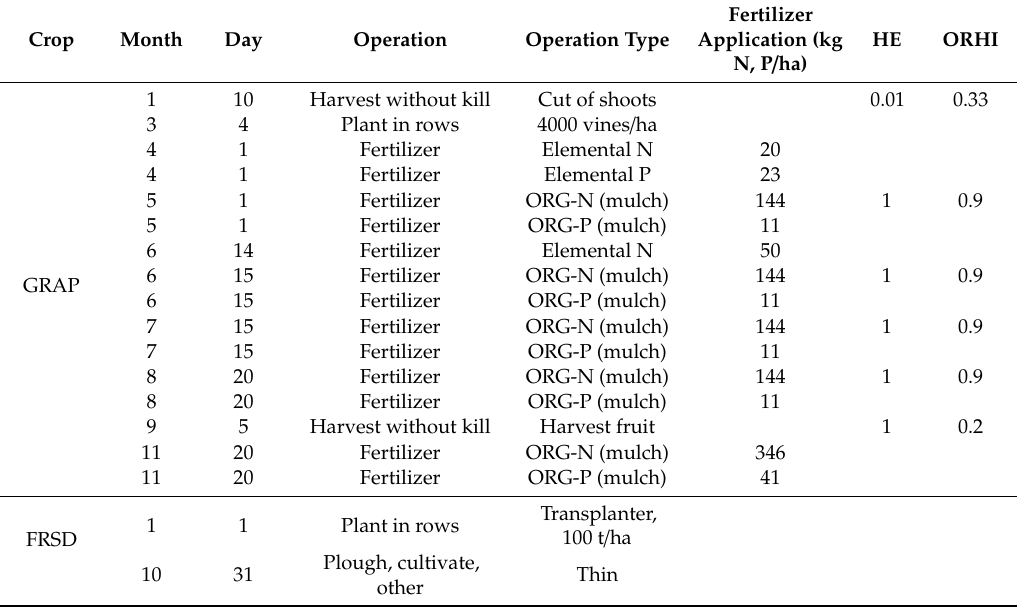
Table 4. Agricultural management task calendar for vineyard (GRAP) and forest (FRSD) land uses in the APEX